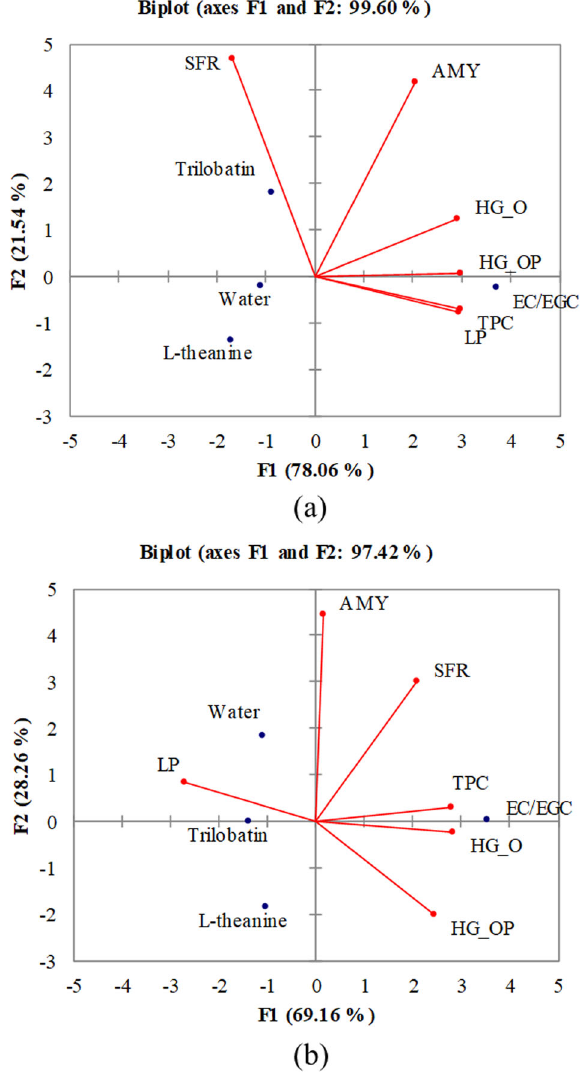
Fig. 3 Principal component analysis of human saliva after the consumption of the sample. a , b The sensitive and non-sensitive group, respectively. The salivary fl ow rate, total protein content, α - amylase activity, lipase activity, Huigan intensity rated in oral stage and Huigan intensity rated in oral-pharyngeal stage are denoted as SFR, TPC, AMY, LP, HG_O, and HG_OP,